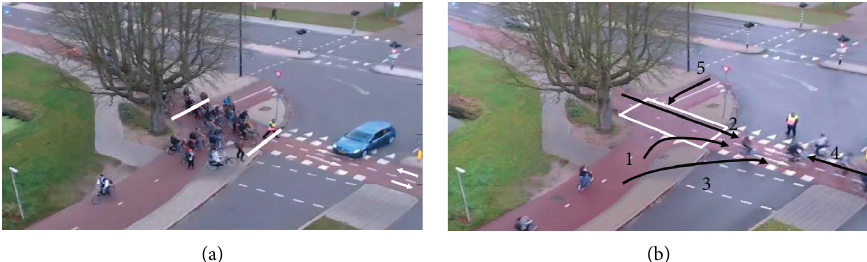
Figure 3: Example of the video data (a) with the waiting area defined by the white lines. The black arrows indicate different directions in which additional cyclists can influence the queue discharge process